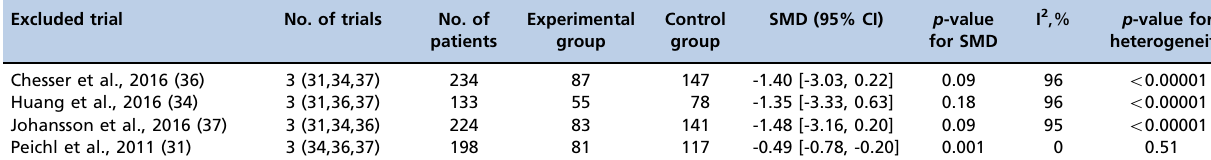
Table 5 - Sensitivity analyses based on various exclusion criteria for the subgroup of fracture pain degree by VAS scores. Excluded trial